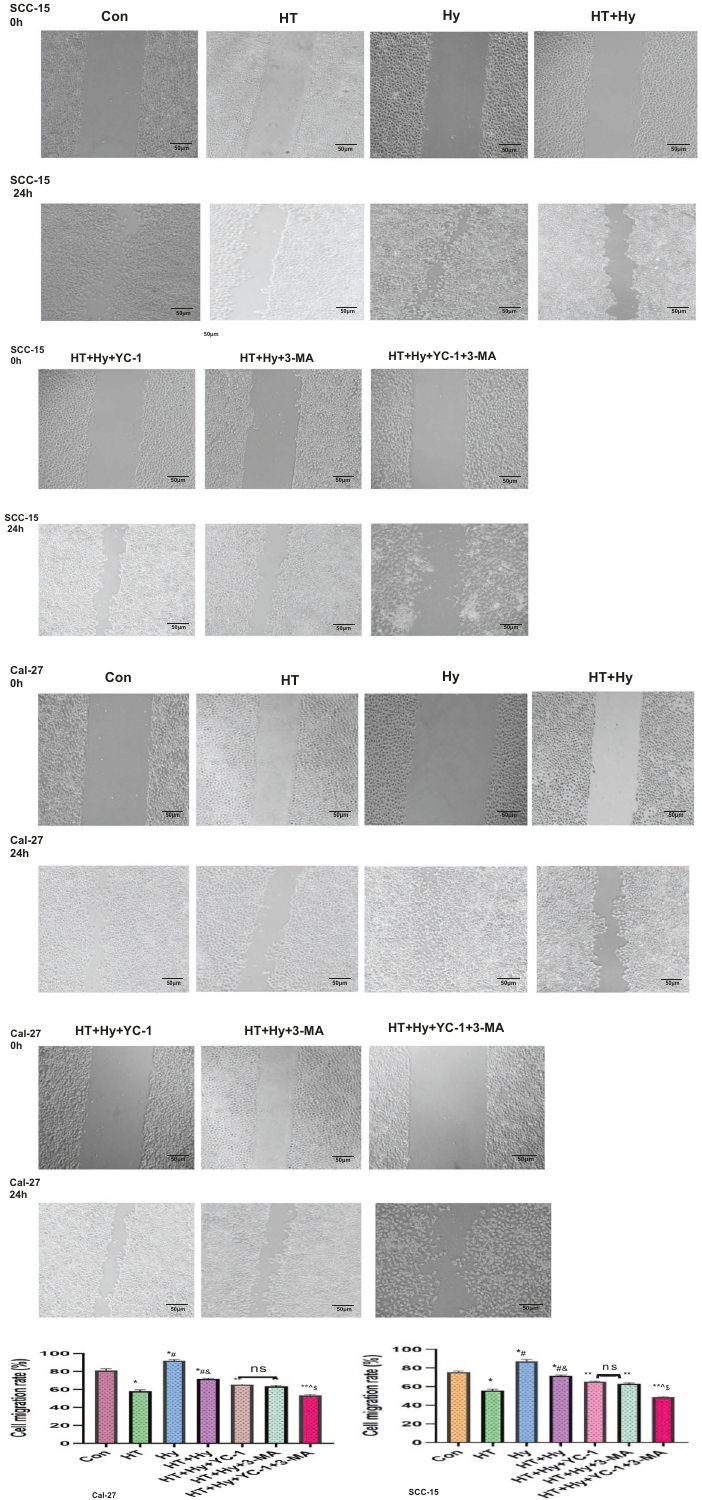
Fig. 2 HT combined YC-1, 3-MA alone or both inhibited the migration of Cal-27 and SCC-15 cells in hypoxia and starvation microenvironment, as determined by wound healing assay. Magni fi cation, ×400. Data were expressed as the mean ± SEM from three independent experiments. Con control, HT hyperthermia, Hy hypoxia; YC-1: 3-(5 ′ -hydroxymethyl-2 ′ -furyl) − 1-benzylindazole; 3-MA: 3- Methyladenine; the histogram of cell migration rate after treatments were analyzed. * p < 0.05 vs. Con group; # p < 0.05 vs. HT group; & p < 0.05 vs. Hy group; ** p < 0.05 vs. HT + Hy group; ^ p < 0.05 vs. HT + Hy + 3-MA group; $ p < 0.05 vs. HT + Hy + YC-1 group; ns no signi fi cant difference ( p > 0.05).